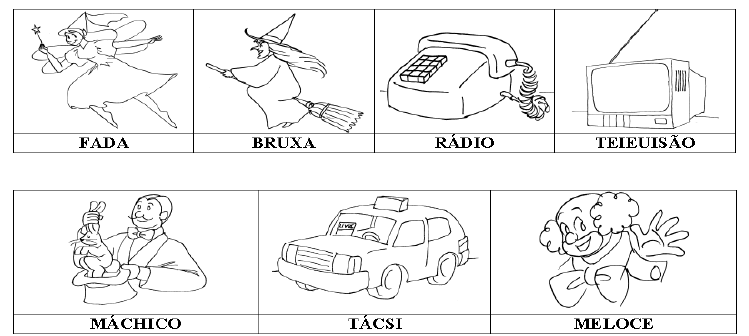
Figure 1 . Examples of items of the WNw-RCT. In order of the presentation: Cor- rect regular words (CR) – the word ‘ FADA ’ (fairy) on the fi gure of a fairy; correct irregular words (CI) – the word ‘ BRUXA ’ (witch) on the fi gure of a witch; semantic changes (SC) – the word ‘ RÁDIO ’ (radio) on the picture of a phone; visual changes (VC) – the word ‘TEIEUISÃO’ (a visual distortion) on the fi gure of a television; phonological changes (PC) – the word ‘MÁCHICO’ (with a wrong sound) on the fi gure of magic; homophone non-words (HN) – the word ‘TACSI’ (a non-word with the same sound than TAXI) on the fi gure of a taxi; and weird non-words (WN) – the word ‘MELOCE’ (a word that does not exist) on the fi gure of a